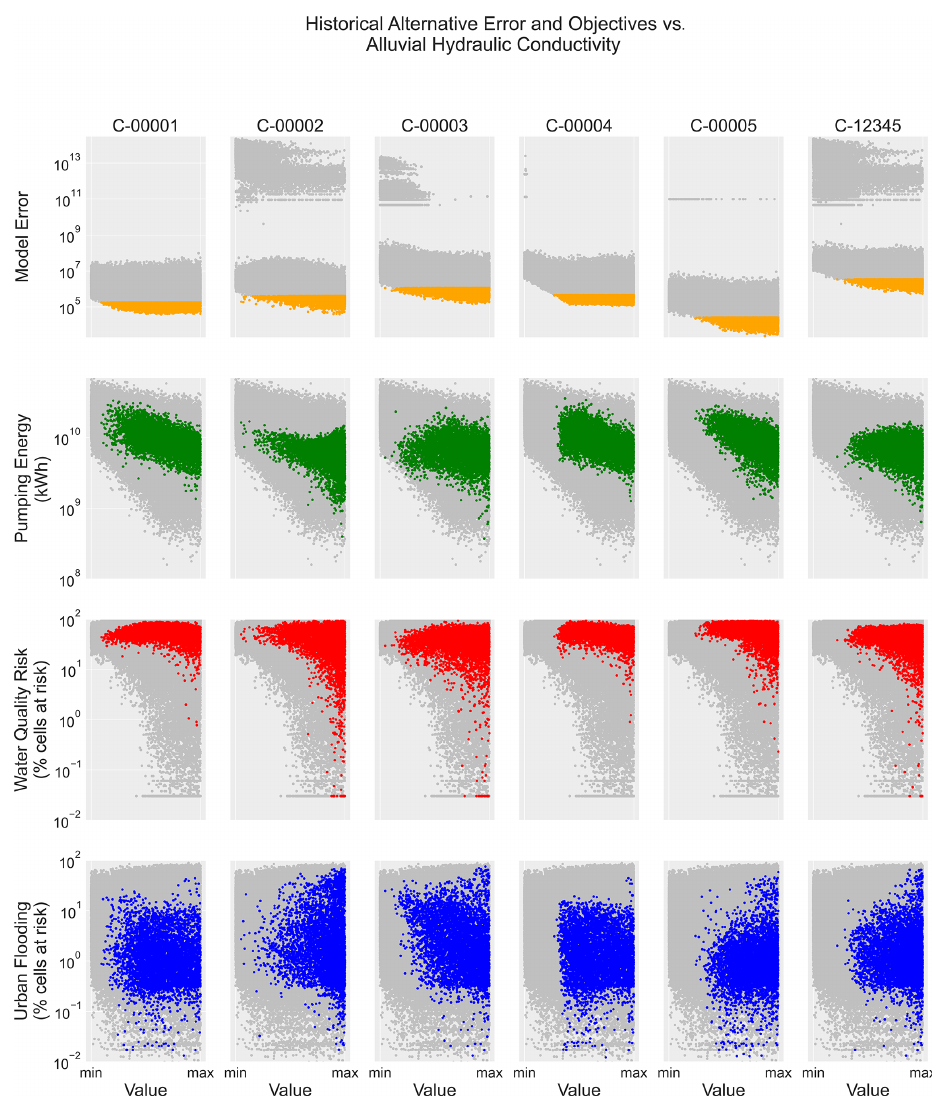
Figure 4. A representative view of the four model output metrics for the historical alternative, plotted against the parameter range for the hydraulic conductivity of the alluvial formation (the most sensitive parameter from Fig. 3). These include the error metric (sum of squared weighted residuals; dimensionless), energy objective (kWh), water quality risk objective (percent of cells not meeting the objective), and urban flooding objective (percent of cells not meeting the objective). Gray points represent all parameter sets, while colors represent behavioral parameter sets meeting the error